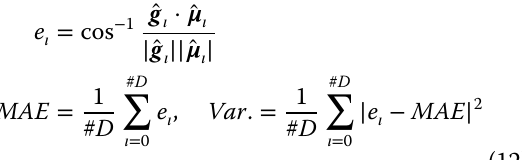
Bold value represents the best result in each experiment/validation